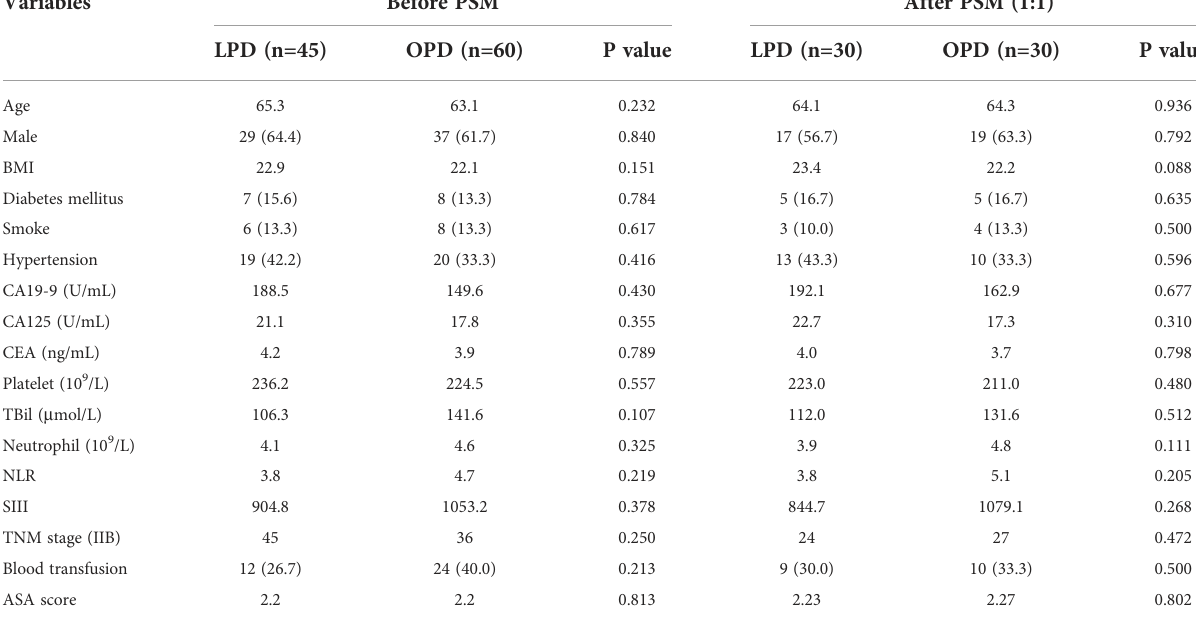
TABLE 1 Comparisons of patients ’ clinicopathologic characteristics between patients with DCC underwent LPD and OPD before and after propensity score matching. Variables